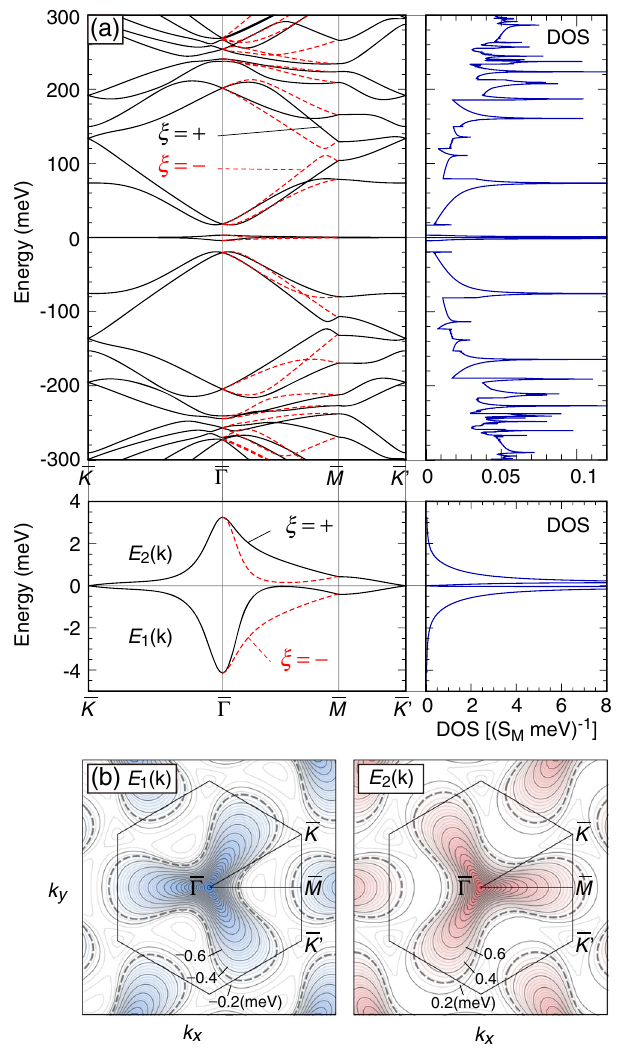
FIG. 2. (a) Energy band and the density of states of TBG at θ ¼ 1 . 05 °, where the lower panel is the enlarged plot of the zero-energy region. The black solid line and red dashed line represent the energy bands of ξ ¼ (cid:4) valleys, respectively. (b) Contour plots of E 1 ð k Þ and E 2 ð k Þ for the valley ξ ¼ þ . The dashed contour corresponds to the filling of two electrons/ holes per supercell ( n=n 0 ¼ (cid:4) 2 ¼ spin and valley included. Here, n 0 ¼ 1 =S , S ffiffiffi p M M ð 3 = 2 Þ L 2 is the moir´e unit area (the band gap is M n=n 0 ¼ (cid:4) 4 ) and L is 13.4 nm at θ ¼ 1 . 05 °. The filling M of two electrons/holes per supercell ( n=n 0 ¼ (cid:4) 2 ) corre- sponds to E ≈ 0 . 289 meV and − 0 . 286 meV, respectively, which are indicated by dashed contours in Fig. 2(b).